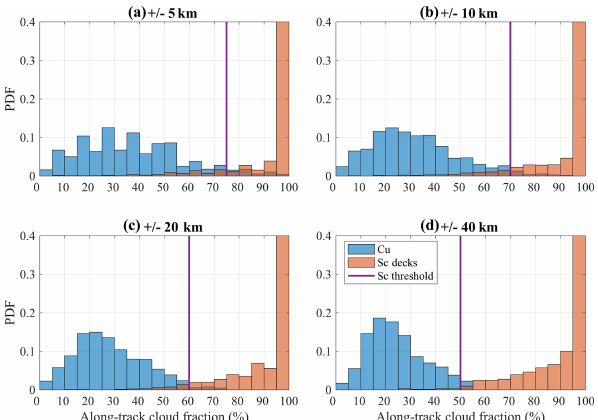
Figure 4. PDF of the different along-track CHCFs for Cu (blue) and Sc (light red) typical regions computed from eight orbit seg- ments. The thresholds are represented in purple, at approximately the overlap of the two